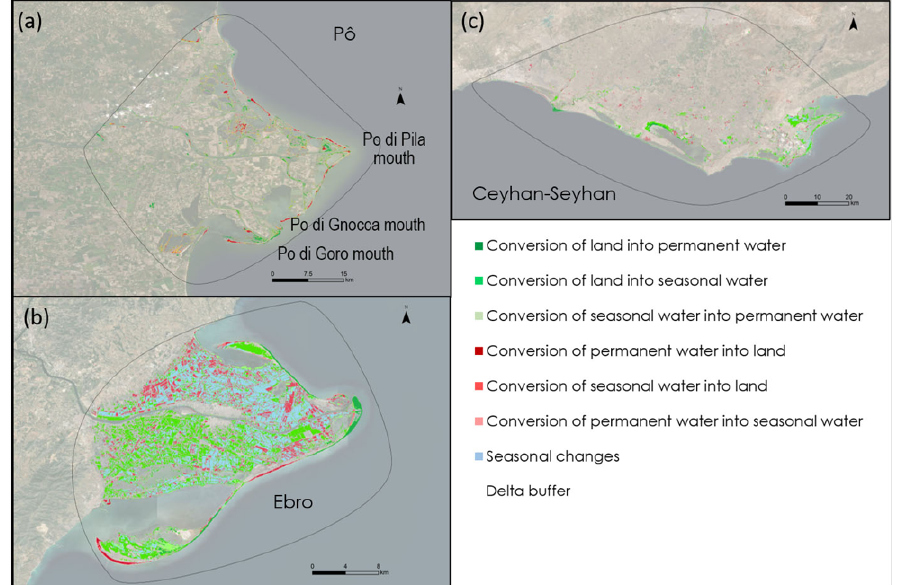
Figure 4. Maps of categories of land → water and water → land conversions for the Po ( a ), Ebro ( b ), and Ceyhan-Seyhan deltas ( c ), culled from the Global Surface Water (GSW) database [7]. The spatial pattern shows relatively strong (78%–91%) delta-plain changes. Basemap: Esri, DigitalGlobe, GeoEye, Earthstar Geographics, CNES/Airbus DS, USDA, USGS, AeroGRID, IGN, and the GIS User Community.